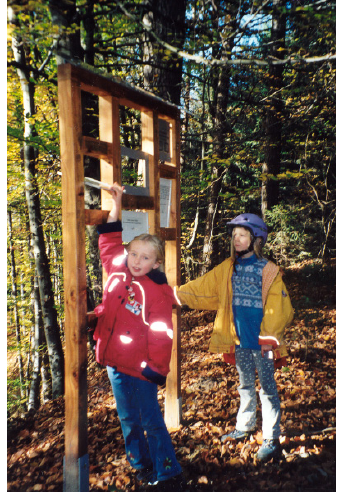
Figure 8. Station clearly too high for the target group of children (Spring Experience Trail, Stockach, Germany) (Megerle 2001).